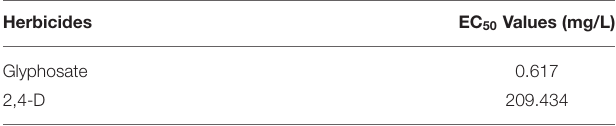
TABLE 2 | Acute toxicity of herbicide formulations on Nostoc sp. N1